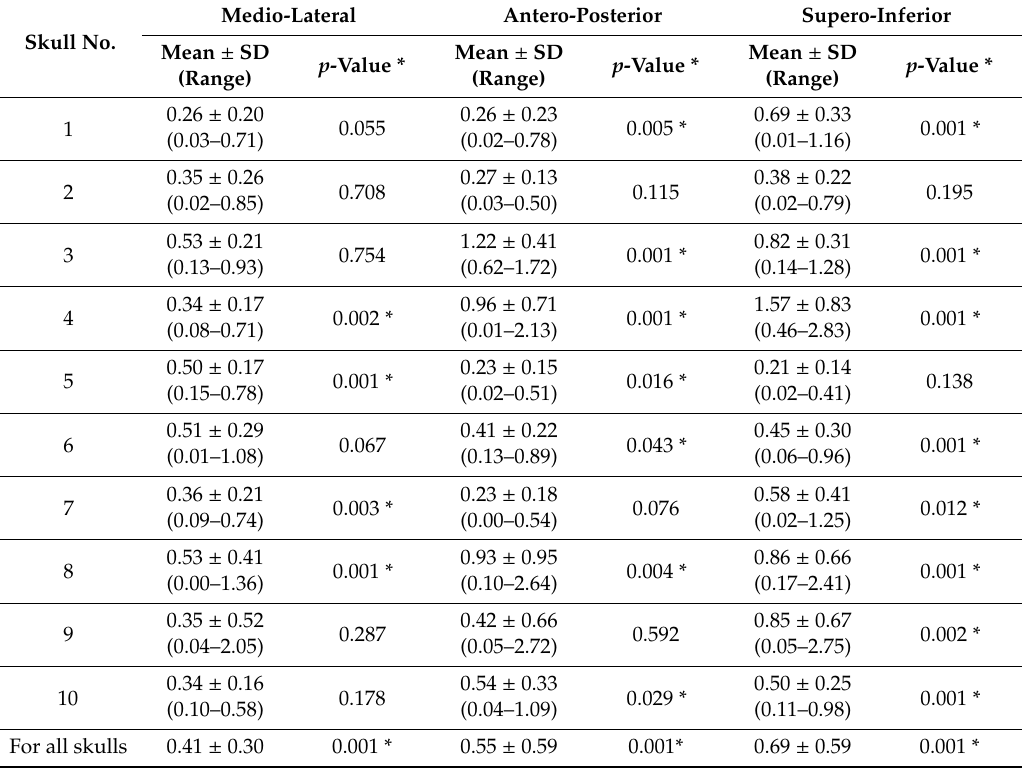
Table 1. Absolute deviation in the medio-lateral, antero-posterior, and supero-inferior directions between the planned and actual positions for the reference structures of the surgical template (mm). Skull